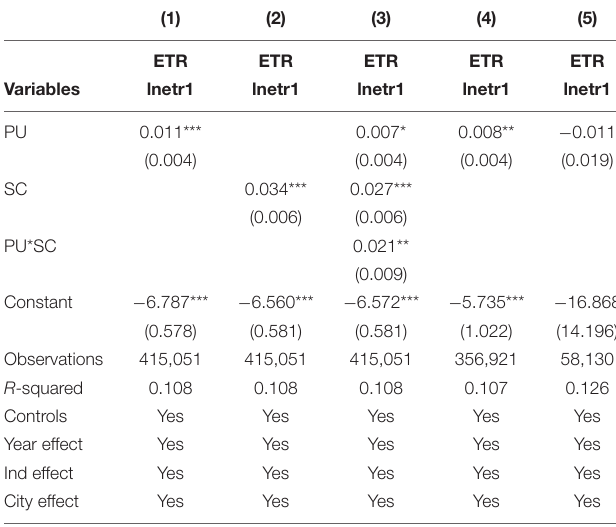
TABLE 7 | Results of regression analysis after excluding 35 large and medium-sized